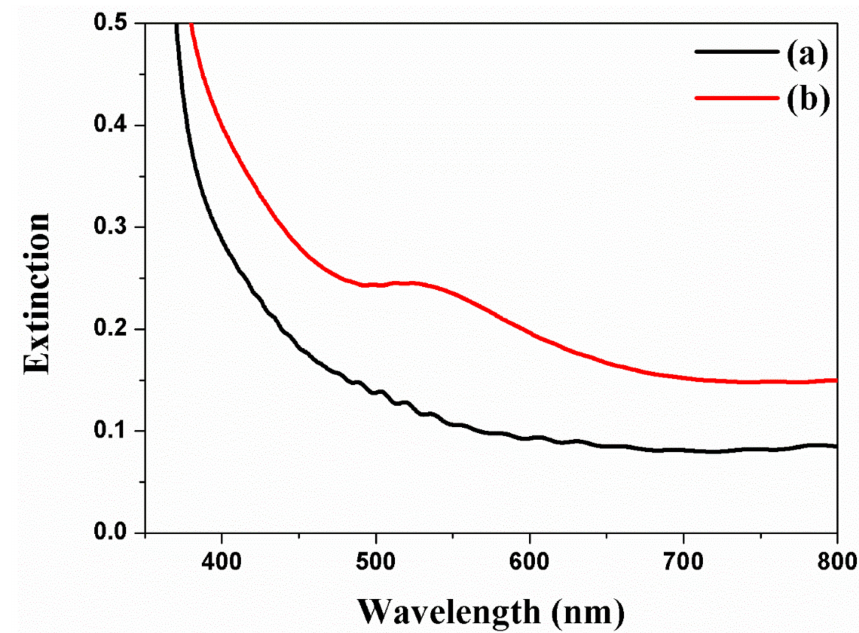
Figure 4. UV-Vis spectra of freestanding TNTAs using Au NPs by means of the electrodeposition method. ( a ) Freestanding TNTAs and ( b ) freestanding TNTAs with Au